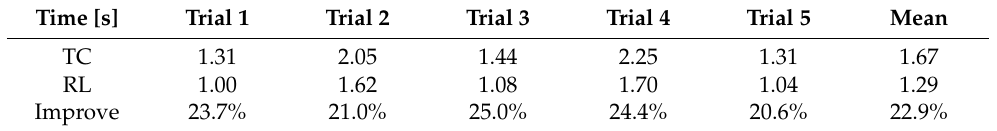
Table 7. The results of speed optimization using via points selected by Tester